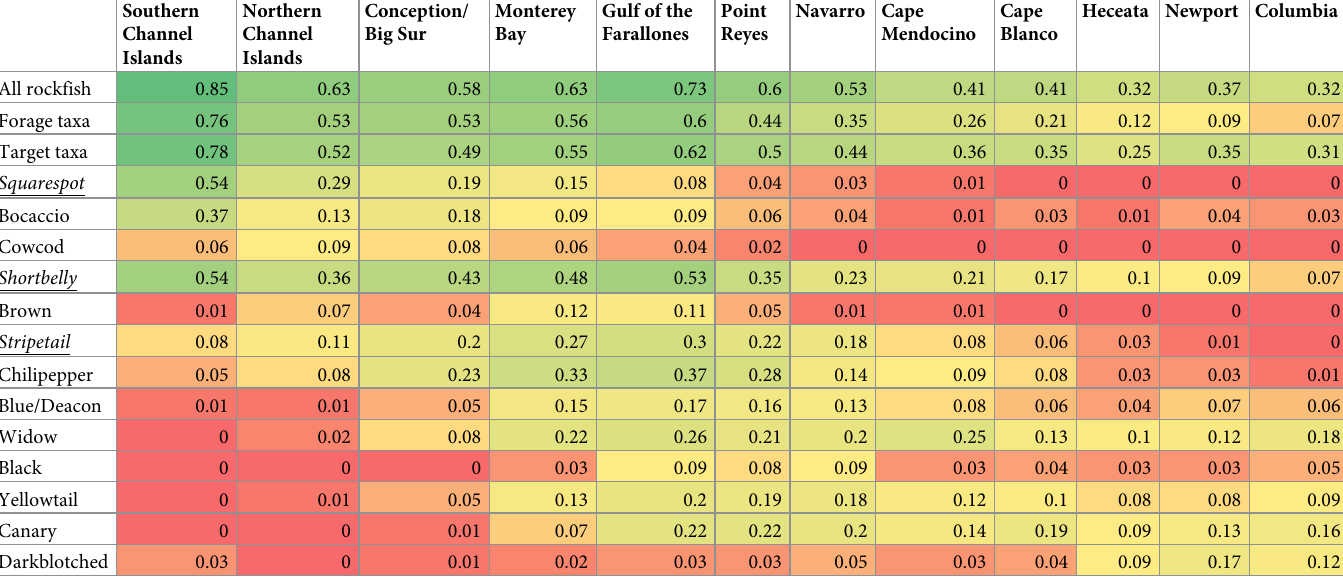
Table 2. The frequency of occurrence (climatology years only) of positive tows by rockfish species and region, for the historical “top ten” rockfish taxa, as well as several others of commercial significance (black rockfish, cowcod, and darkblotched rockfish) and pooled groups (for scientific names and group designations see S1 Table).